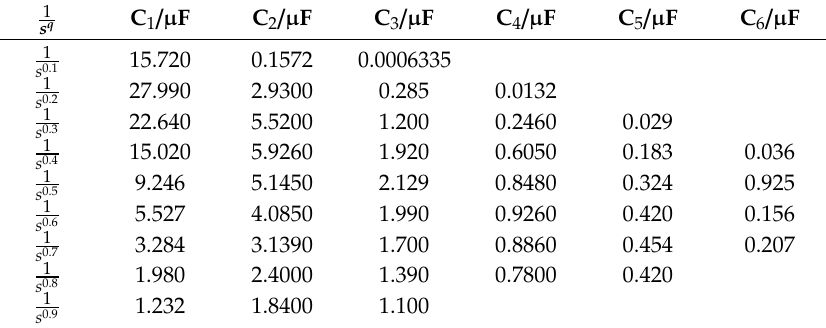
Table 3. Capacitance value in q -order fractional unit circuit.